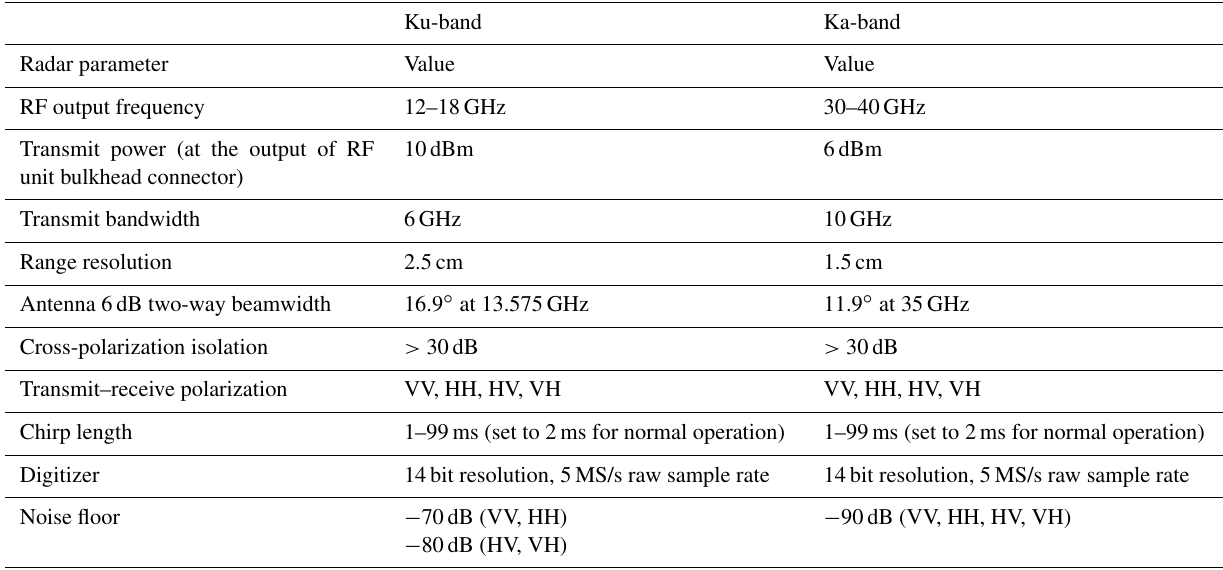
Table 1. Summary of Ka- and Ku-band